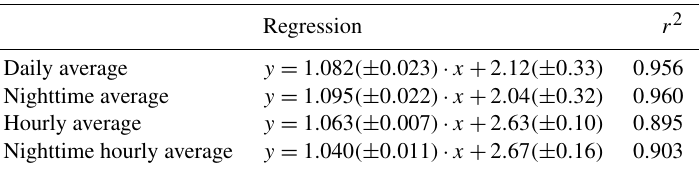
Figure 2. Comparisons between PM 2 . 5 values from BAM 1020 (FEM) and pDR-1500 in terms of (a) 24h average, (b) Nighttime (22:00 to 06:00 LT) average, (c) hourly average and (d) nighttime hourly average. The apparent horizontal lines in (c) and (d) result from the 1µgm − 3 resolution of the hourly BAM readings. Table 3. Comparisons between BAM 1020 ( y ) and pDR-1500 ( x ) from December 2011 to April 2012 in Rutland, VT. The values inside the parentheses represent the corresponding one standard